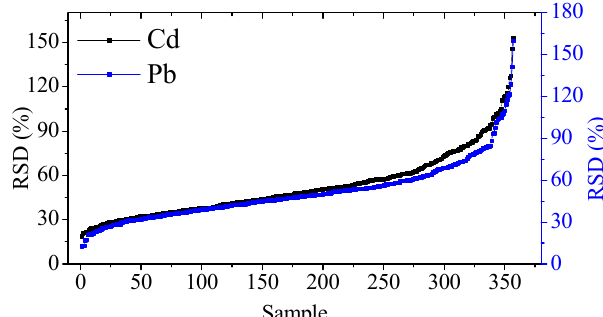
Figure 4. The single-pulse RSD values of Cd and Pb.